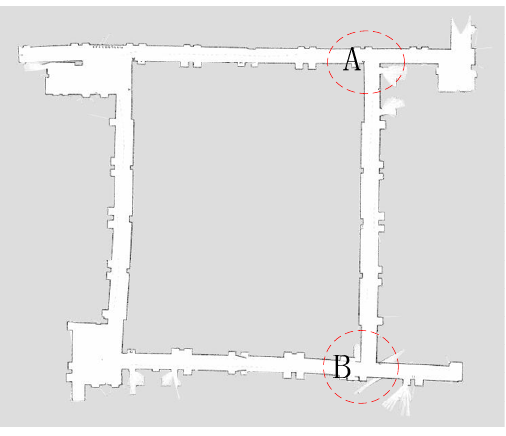
Figure 11. Map of the indoor looped corridor after the calibration.